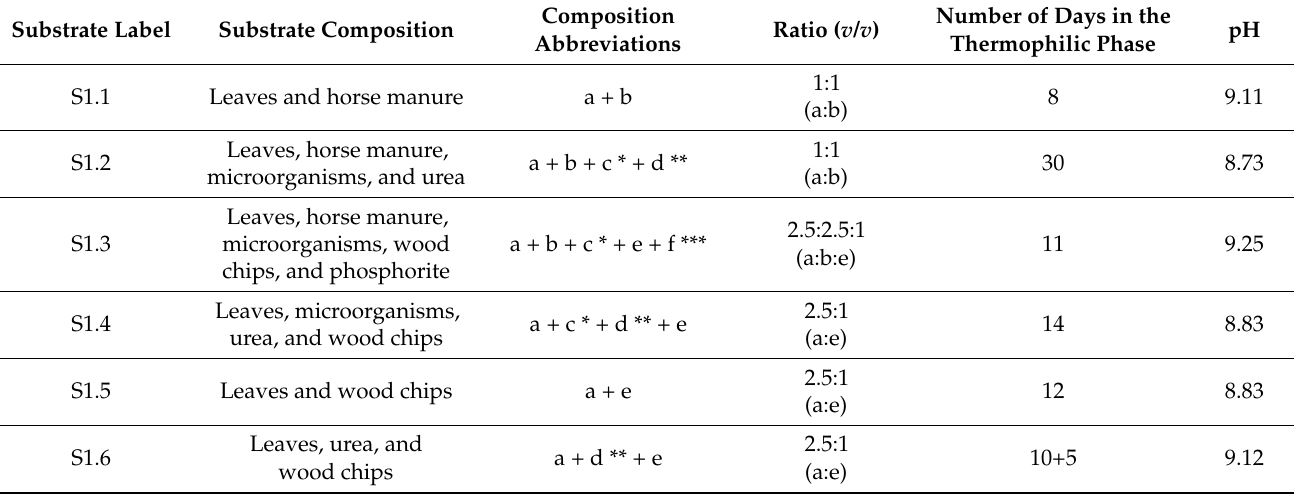
Table 1. Details of the first set of